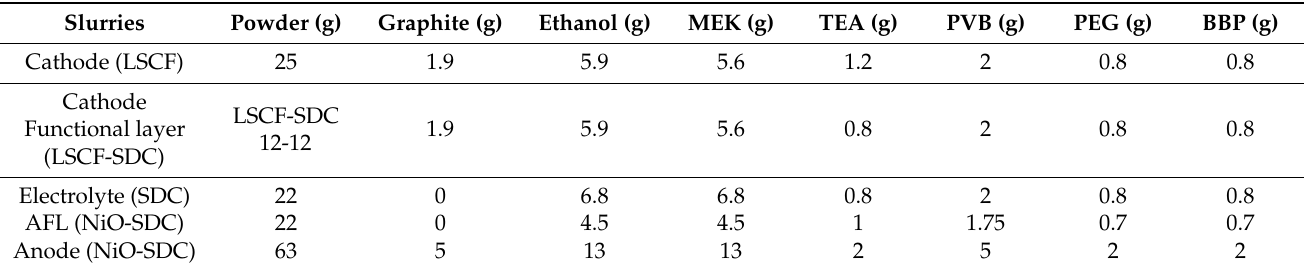
Table 1. Quantities used for slurries